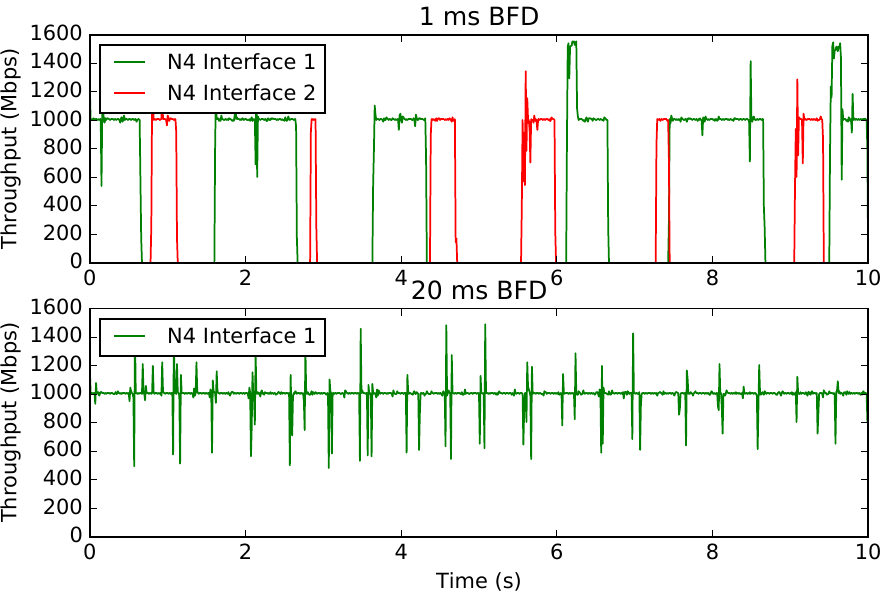
Figure 12. Throughput over time for an 1 Gbps UDP